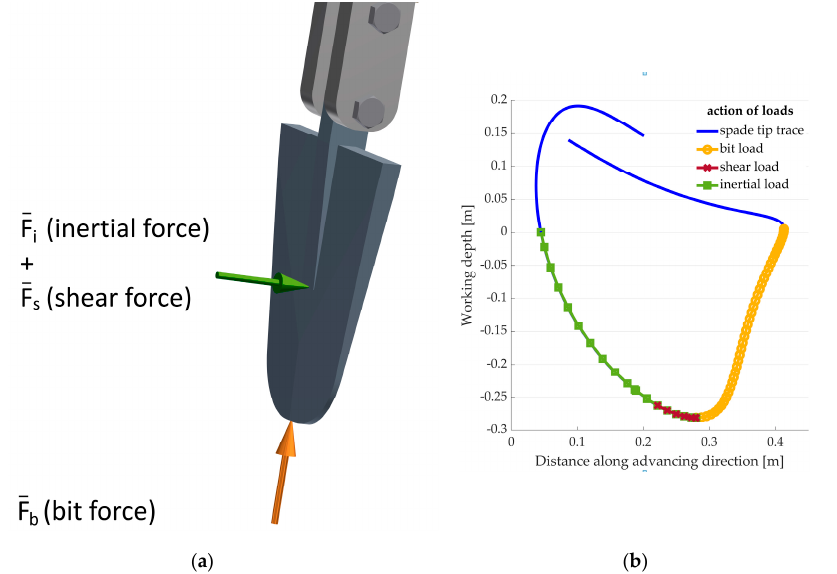
Figure 8. ( a ) The acting points of the forces resulting from the soil tillage during the spade use; ( b ) the acting intervals of the forces relative to the working